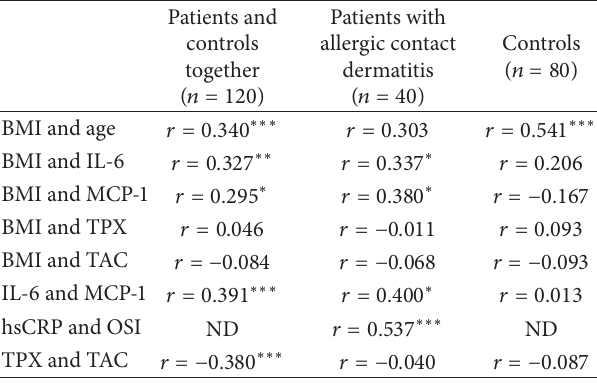
Table 2: Correlations between inflammatory and oxidative stress markersandtheircorrelationswithsubjects’ageandBMIinpatients with allergic contact dermatitis and healthy